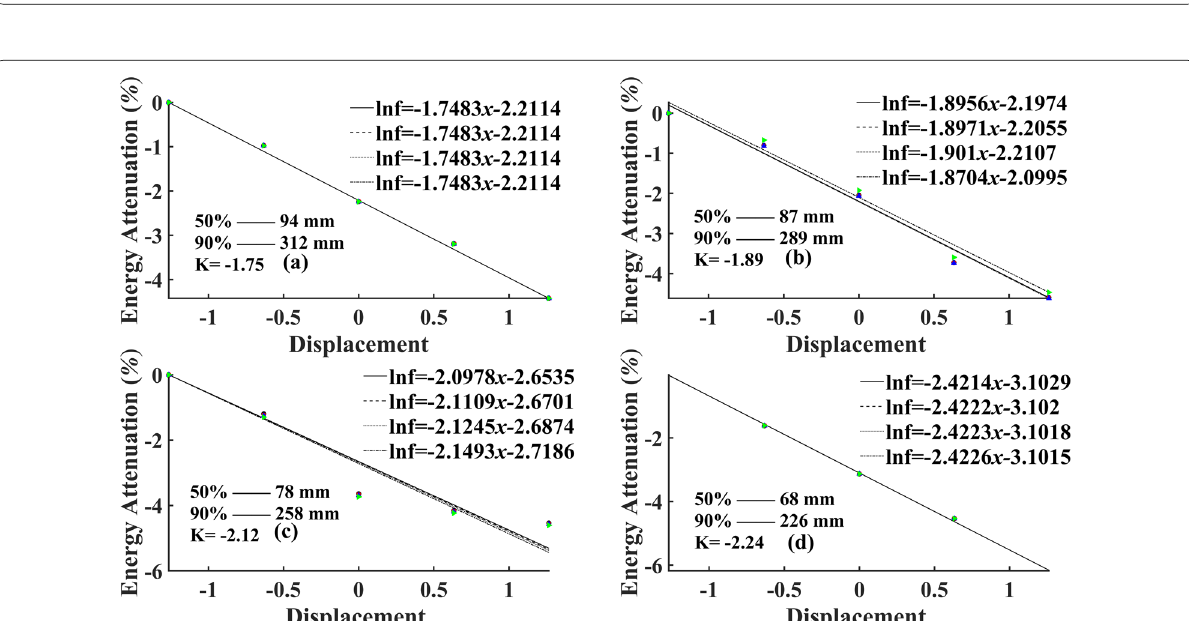
Fig. 8 Fitting curve of AE longitudinal wave energy